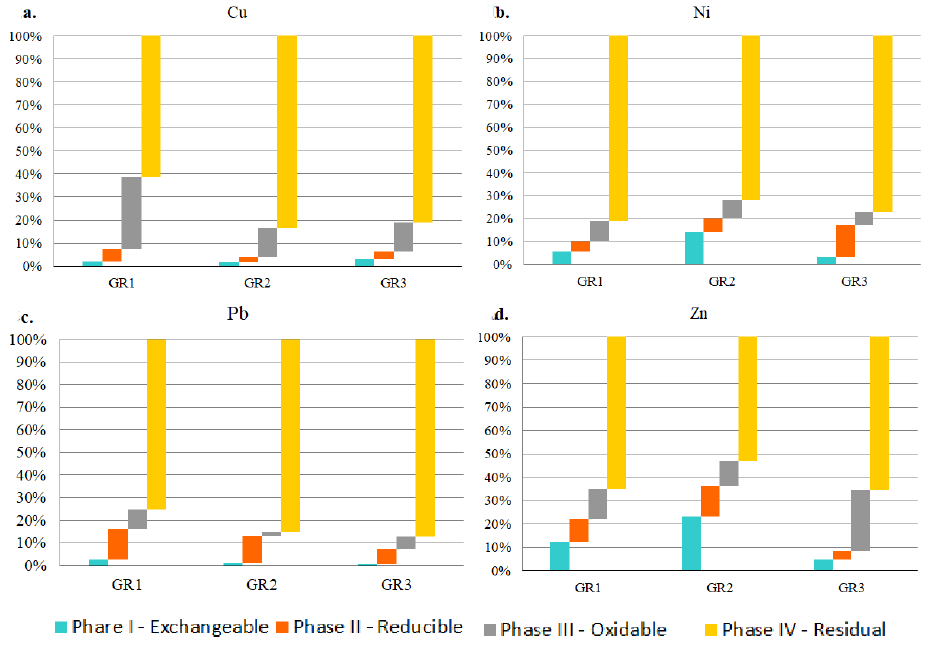
Figure 3. Histograms of the Cu, Ni, Pb and Zn sequential extraction ( a – d ) respectively in the topsoil horizons (A and AC) of soil profiles in mining rocks deposits (GR1), soils formed on coarse debris of mining landfill or on altering mine debris (GR2), soils formed on mining flotation depos-its (GR3).